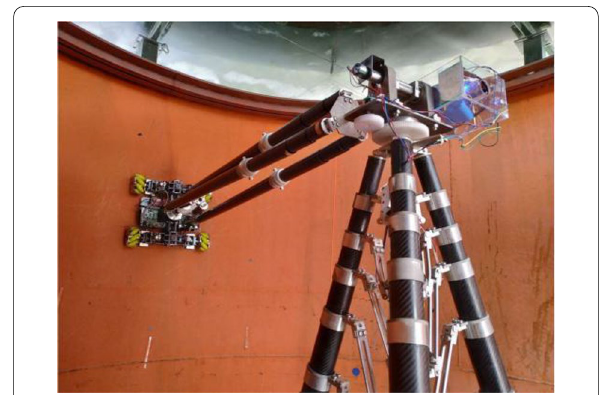
Figure 18 Robot connected with the cantilever